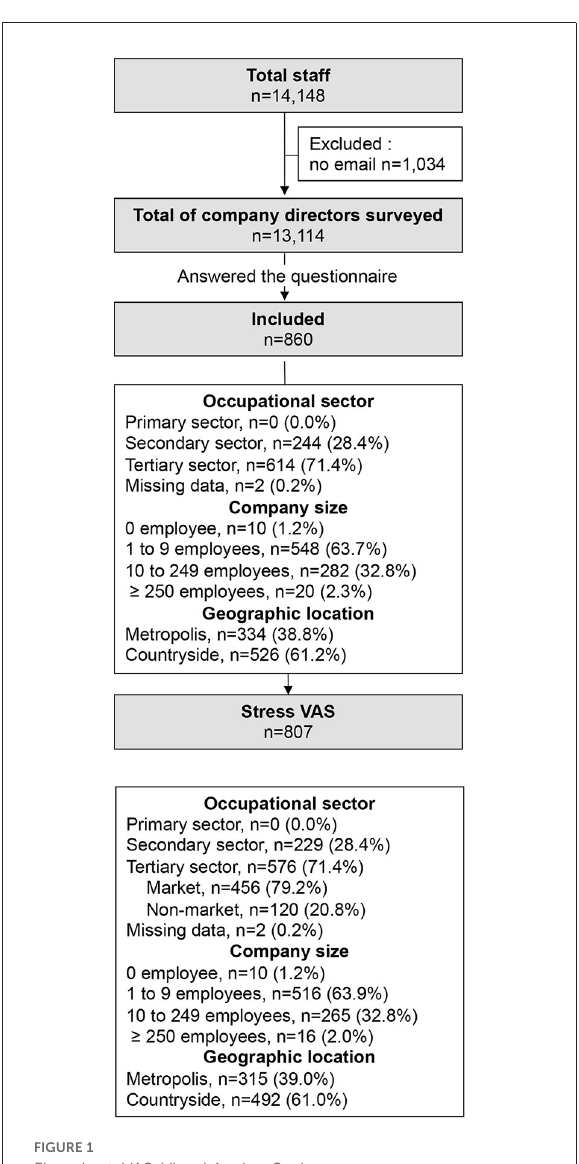
FIGURE1 Flowchart. VAS, Visual Analog Scale.